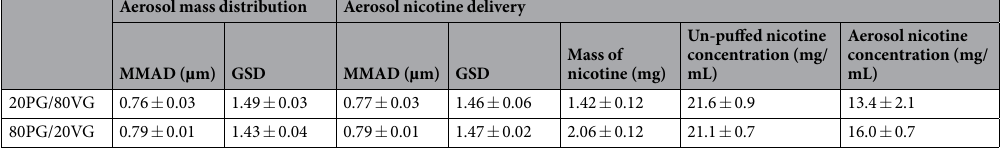
Table 1. Summary of the size distribution data. Experiments were performed in triplicate with a power level fixed at 15 W, a dilution ratio of 1.5 and a same volume of aerosol collected into the cascade impactor for all experimental conditions. MMAD referred to the Mass Median Aerodynamic Diameter. GSD referred to the geometric standard deviation of the mass aerosol distribution.